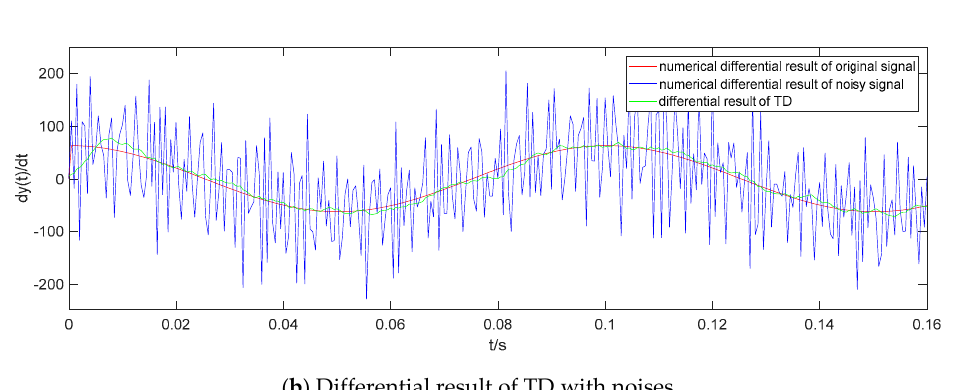
Figure 3. Filtering result and differential result of TD with noise.